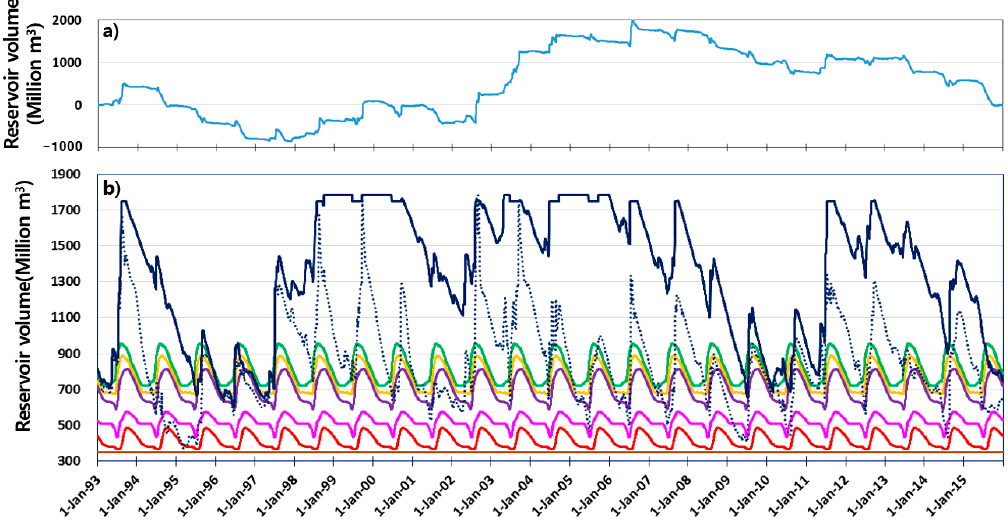
Figure 3. Application results of reservoir operation criteria on Andong–Imha Dams in the Nakdong River Basin. ( a ) Reservoir volume (m 3 ) based on the current daily inflow minus the average daily inflow (i.e., the surplus); ( b ) reservoir volume (m 3 ) with respect to past (gray dotted line) and improved (solid black line) operation criteria. Drought stages are presented as normal (Stage 0; green); attention (Stage I; yellow); caution (Stage II; purple); alert (Stage III; pink); serious (Stage IV; red). Extreme drought years are circled in red.